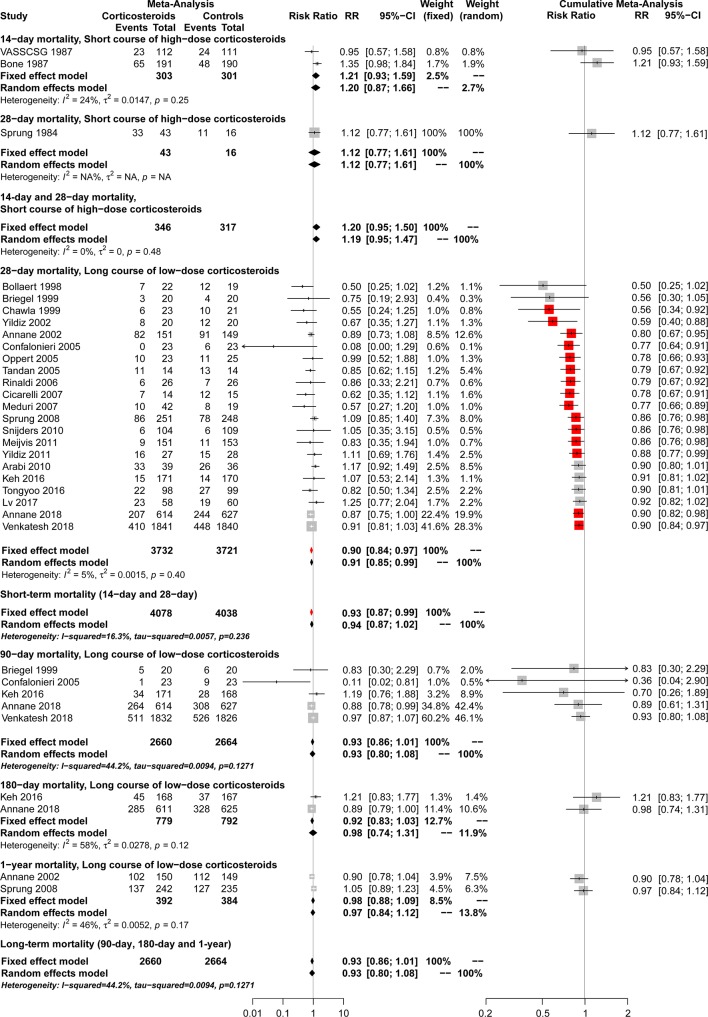
Forest plot of the benefits of corticosteroids for short-term mortality (14-day and 28-day mortality) and long-term mortality (90-day, 180-day and 1-year mortality) from conventional and cumulative analysis.